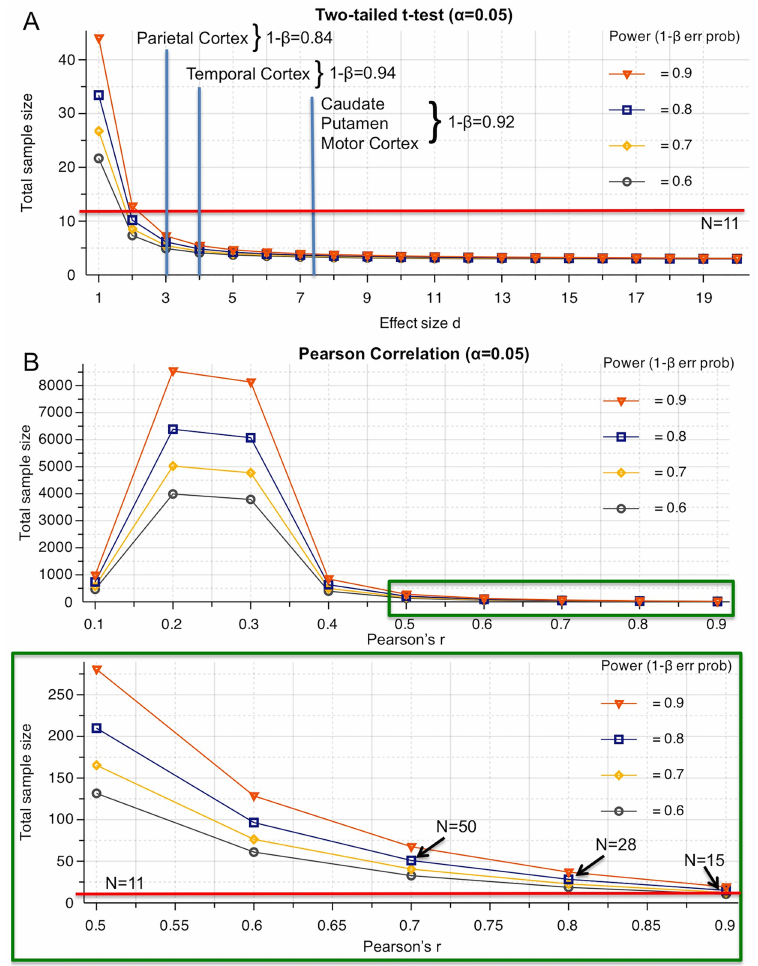
Fig 6. Calculation of statistical power. A. Graphicalrepresentation of total sample size requiredfor a given effect size to achievedifferent levels of statistical power for two-tailed (i.e. if no hypothesisregardingdirection of effect is available) t-test comparisons. The effect size for different comparisons is indicatedin this graph with the corresponding statistical power. With N = 11 in the current experiment, a sufficient statistical power 1- β> 0.8 is achievedto avoid Type II errors (i.e. false negatives)with a Type I error (false positives) rate set at 5% (i.e. p < 0.05). B. Illustration of a power analysisfor Pearson’s correlationsindicatesthat small r values ( < 0.4) require substantial sample sizes to achieve sufficient power to afford a valid comparisonat the 5% Type I error rate. In primate studies small sample size are typical due to availability of subjects. A total sample size of 11 is insufficientto achieve an 80% power even with r = 0.9. Significant correlationswith medium to high associations of measures wouldrequiresample sizes > 50 subjects. In rats, we have previously demonstrated that significantcorrelationsbetweenneuropathologicalmeasurements and MRI can be performed with N = 15 with high associations (r > 0.7) [25, 27].